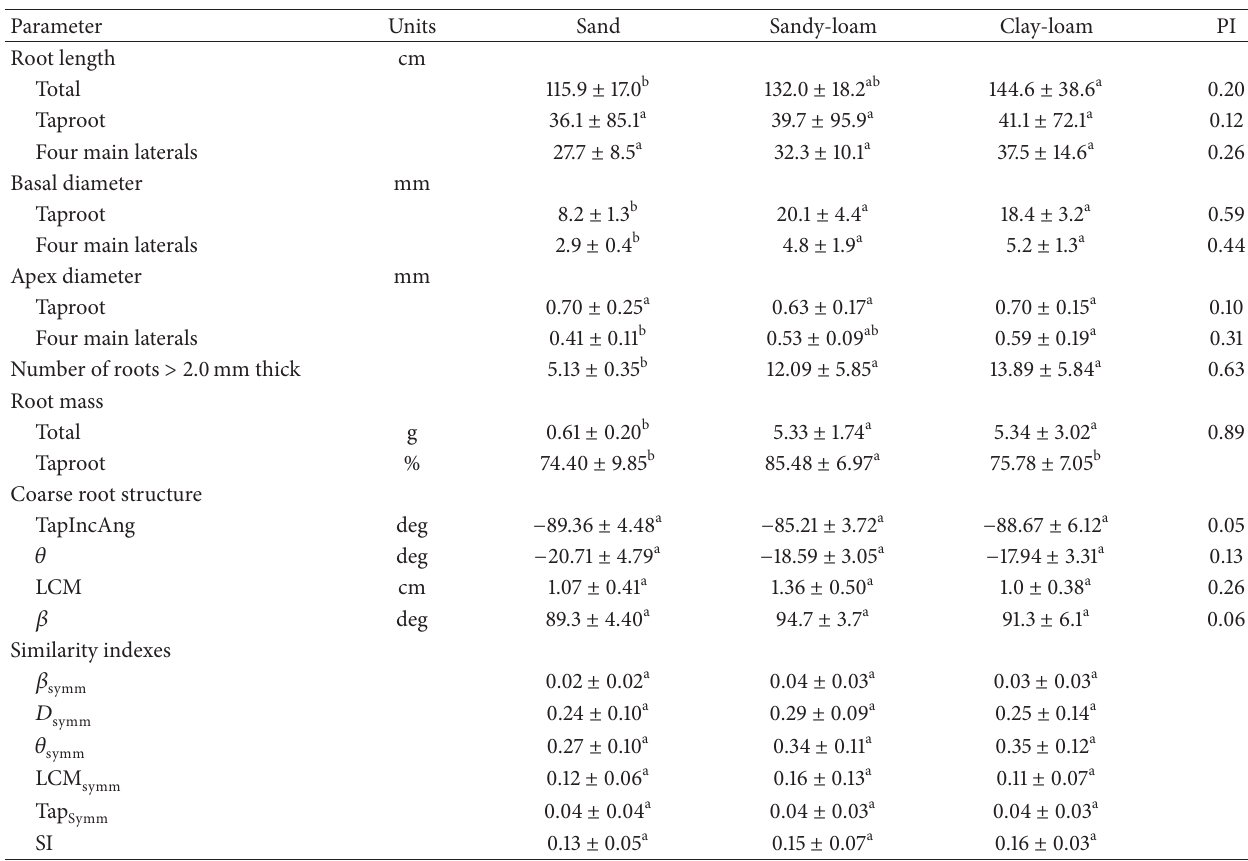
Table 4: Average ± SD below-ground parameters in J. curcas seedlings grown in three different